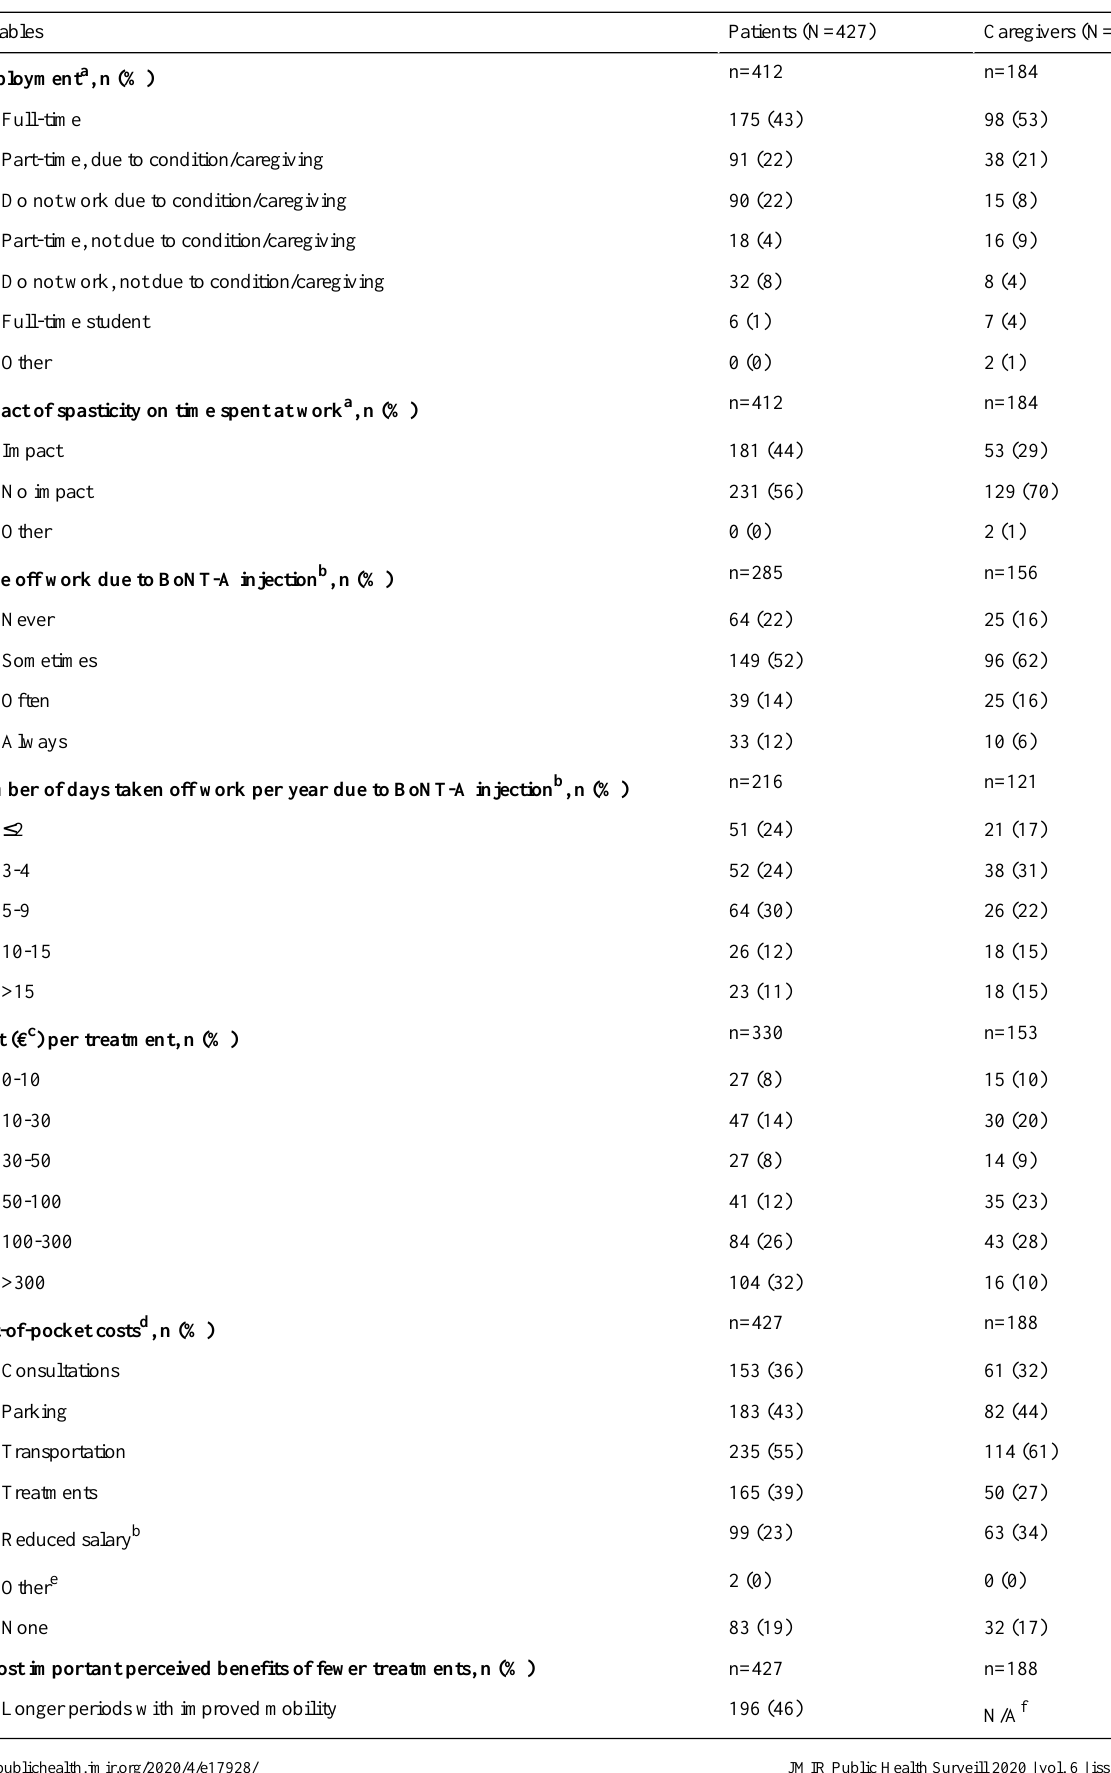
Table 2. Burden of spasticity and botulinum neurotoxin type A (BoNT-A) treatment, and the perceived benefits of fewer BoNT-A treatments, for patients and caregivers